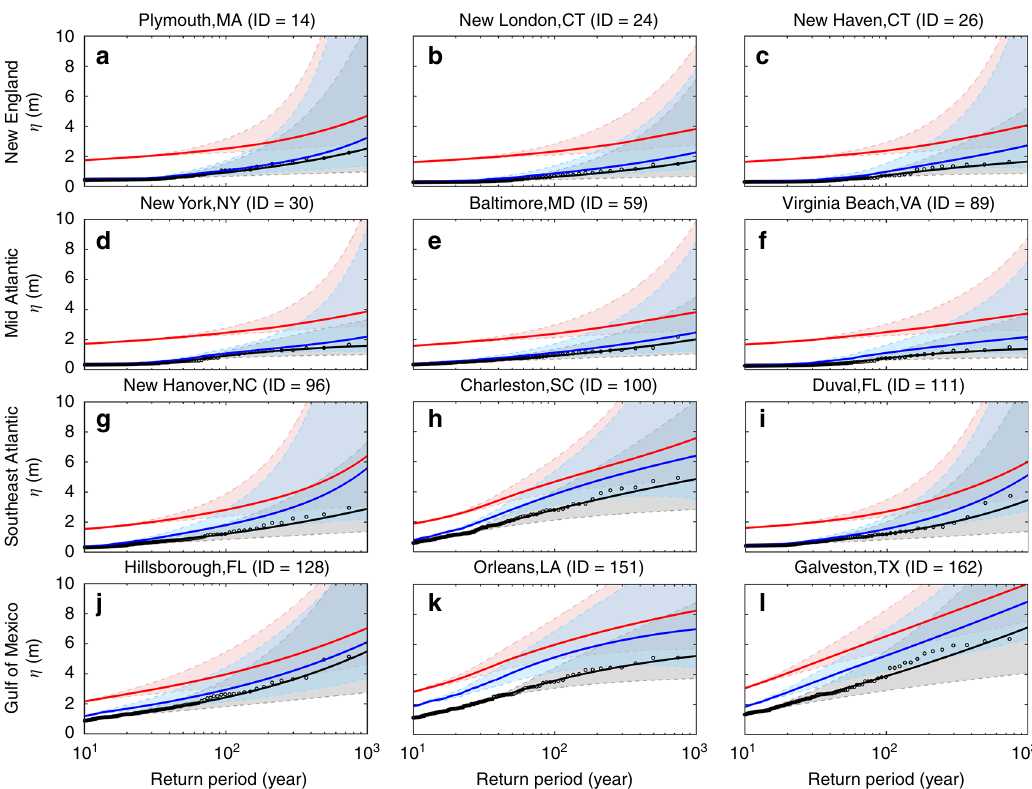
Fig. 2 Flood return period curves for the historical period of 1980 – 2005 (black) and future period of 2070 – 2095 (blue: only effects of TC changes, red: compound effects of SLR and TCs) at selected coastal counties. a – c Representative counties in New England; d – f representative counties in mid Atlantic; g – i representative counties in southeast Atlantic; j – l representative counties in Gulf of Mexico. Empirical data points for the historical period are shown as black circles. Solid lines represent the best estimates of fl ood return periods. Shaded areas cover the very likely range estimates (i.e., 90% statistical con fi dence interval). Future projections are weighted average over the six climate models. Flood levels are relative to mean higher high water (MHHW, obtained from https://vdatum.noaa.gov). Source data are provided as a Source data fi